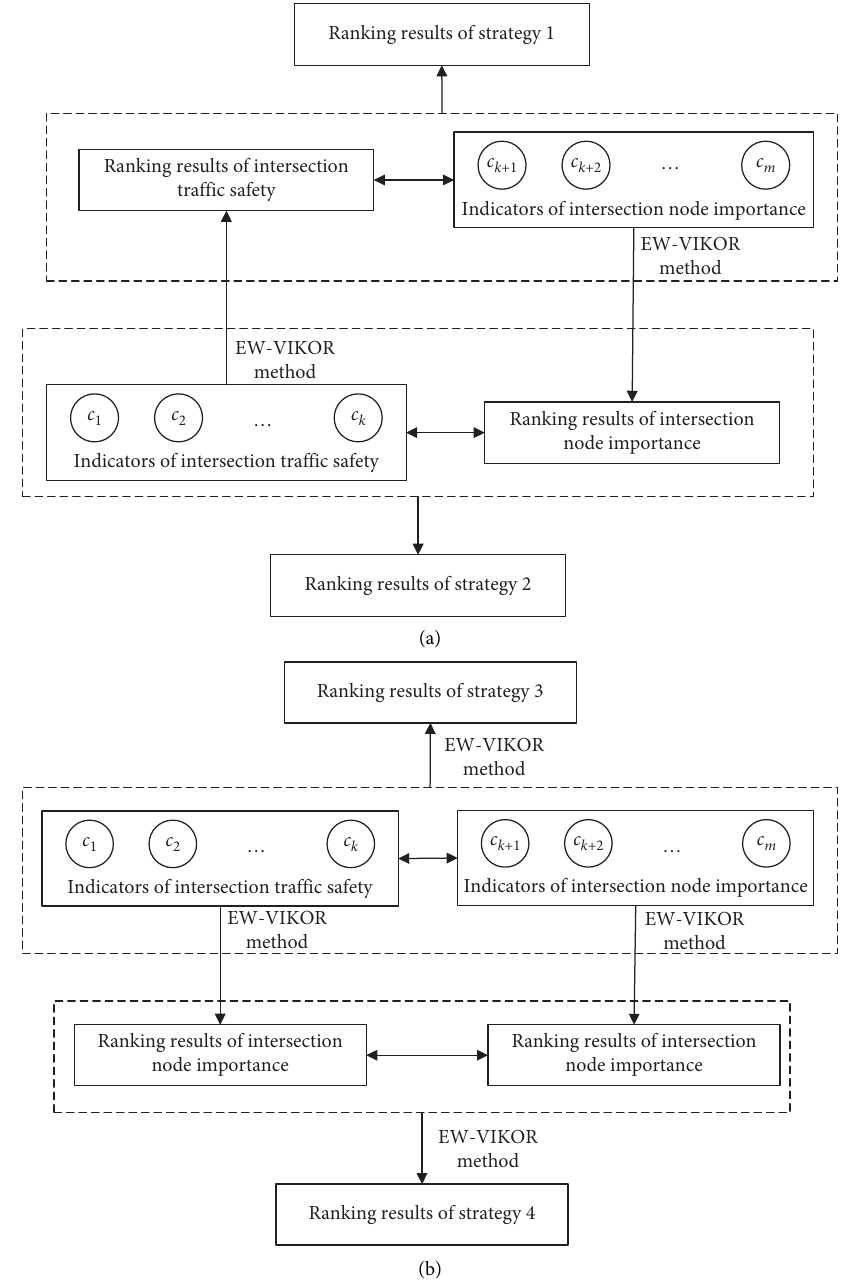
Figure 1: Flow chart of the proposed framework with four strategies: (a) strategies 1 and 2 and (b) strategies 3 and